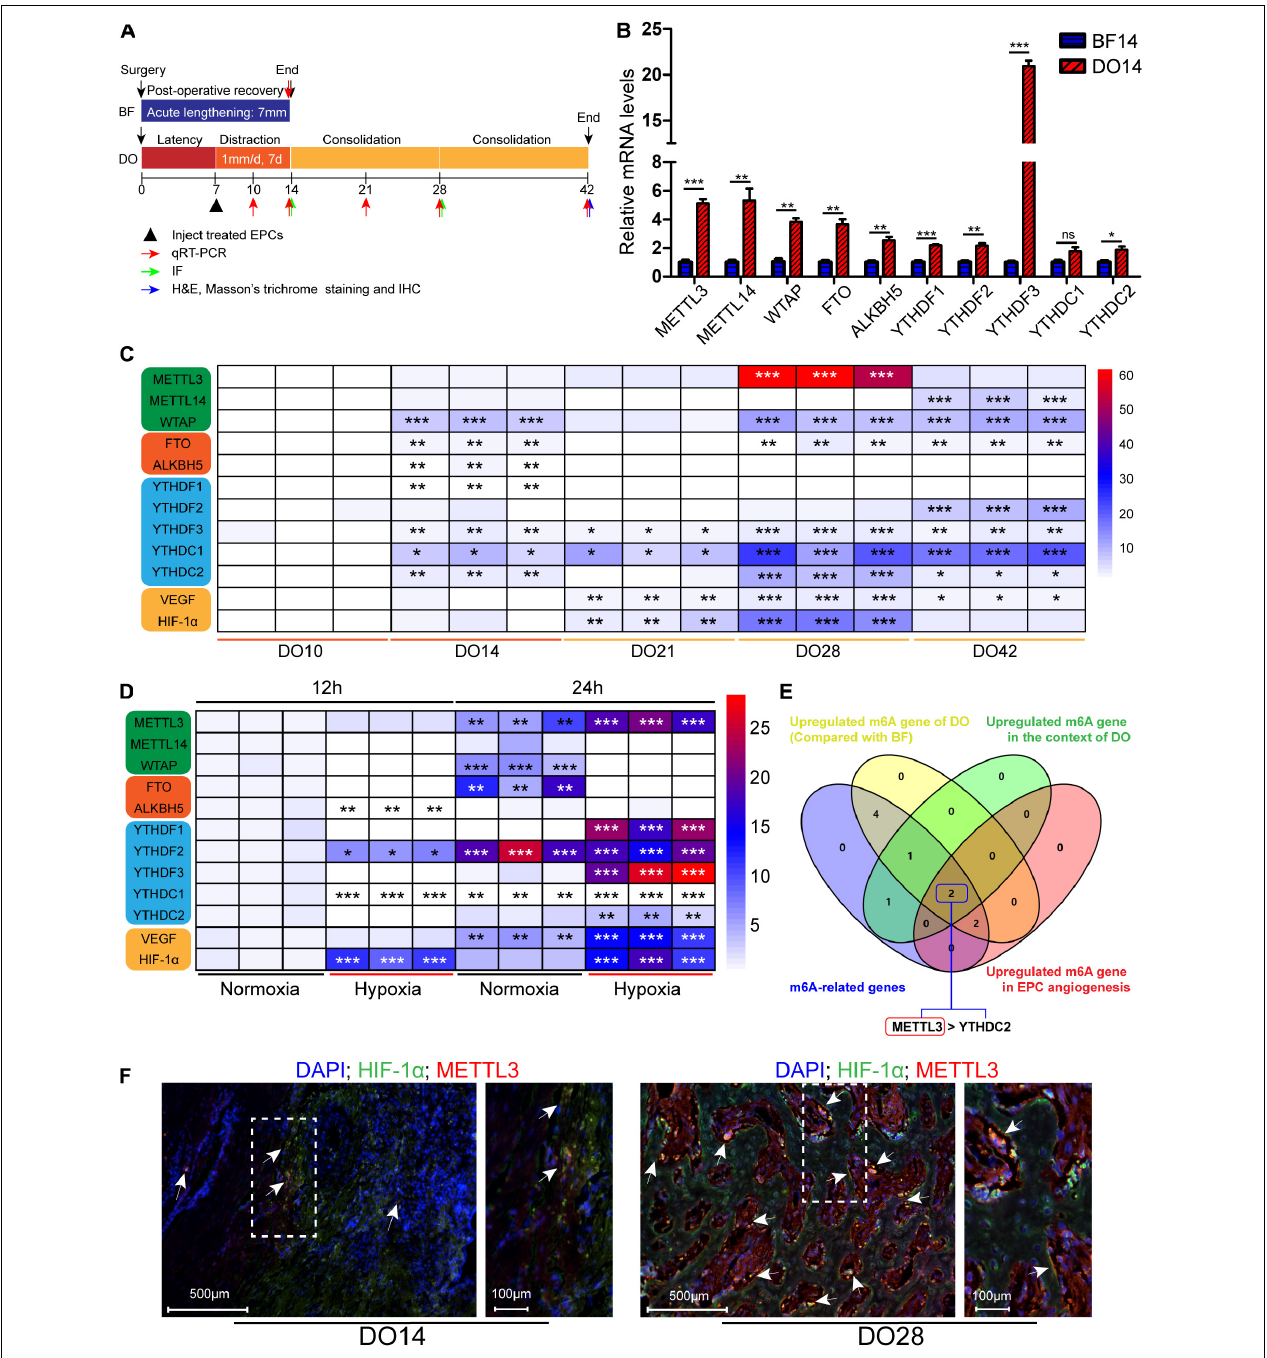
FIGURE 1 | Methyltransferase-like 3 (METTL3) expression is elevated in endothelial progenitor cell (EPC) angiogenic processes related to distraction osteogenesis (DO) regeneration. (A) Schematic overview of the canine DO and BF model employed in this study. (B) quantitative real-time polymerase chain reaction (qRT-PCR) results revealed that m 6 A methylation was increased in the DO callus tissue relative to the bone fracture (BF) model ( n = 3 per group). (C) Heatmap of qRT-PCR results demonstrating the expression of N6-methyladenosine (m 6 A)-related genes during different stages of DO ( n = 3/group). (D) Heatmap of qRT-PCR results in the context of EPC angiogenesis. Endothelial progenitor cells were cultured under hypoxic conditions in vitro to mimic the DO microenvironment. N6-methyladenosine and angiogenic cytokine expression levels were measured following culture for 24 h ( n = 3/group). (E) Venn diagram demonstrating m 6 A-related gene overlap. METTL3 and YTHDC2 were specifically identified, and METTL3 was selected for further study owing to its high expression level. (F) IF staining for METTL3 and HIF-1 α on DO14 and DO28. This analysis revealed that METTL3 was expressed on DO14 (white arrow) with gradual increases at later time points, and HIF-1 α co-expression was also evident ( n = 3/group). Scale bars: 500 and 100 µ m. ns P > 0.05, * P < 0.05, ** P < 0.01, *** P < 0.001. One-way ANOVA with Tukey’s post hoc test . Experiments were repeated in triplicate.